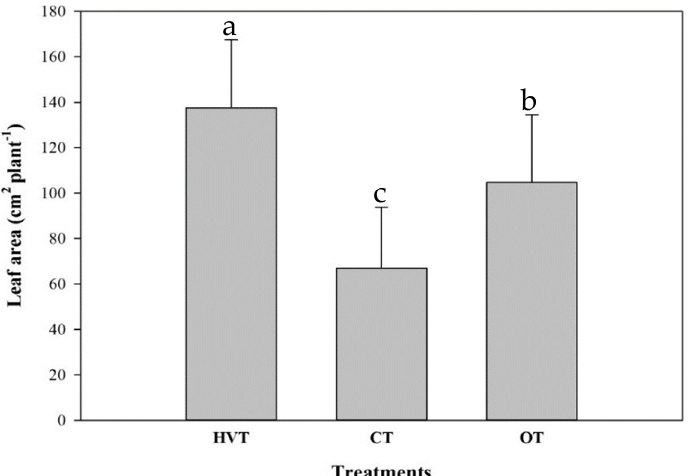
Figure 5. The average leaf area for Pak choi for each treatment. Means followed by the same letter are not significantly different ( p < 0.05, Tukey multiple comparison tests). HVT is the high-temperature oscillation pattern, CT is the fixed temperature regime, and OT is the inside temperature of a net house.